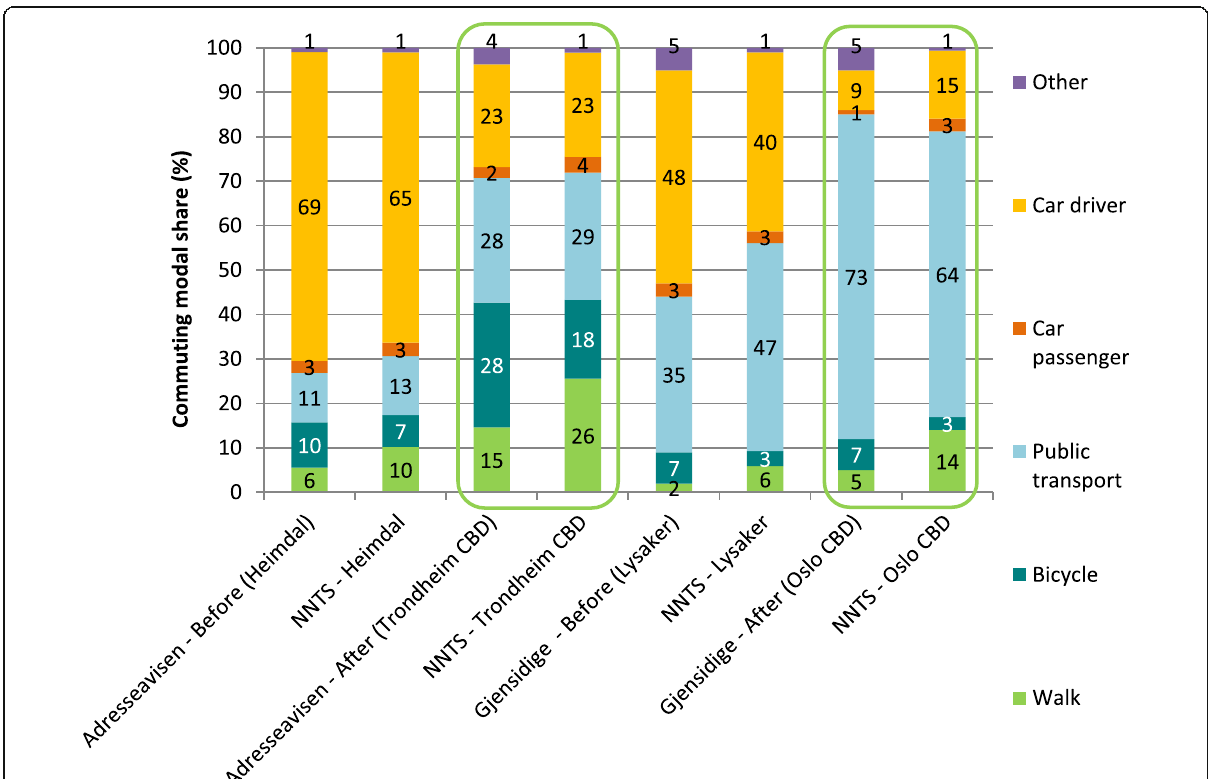
Fig. 4 Commuting transport modal split before and after two central office relocations in Norway: Adresseavisen and Gjensidige. The survey results for both companies are paired with the commuting modal split of the same boroughs using data from the Norwegian National Travel Survey (NNTS) [56]. Note NNTS data for commuting journeys are restricted to those starting/ending in the same and immediately adjacent boroughs ('bydeler') at each respective company